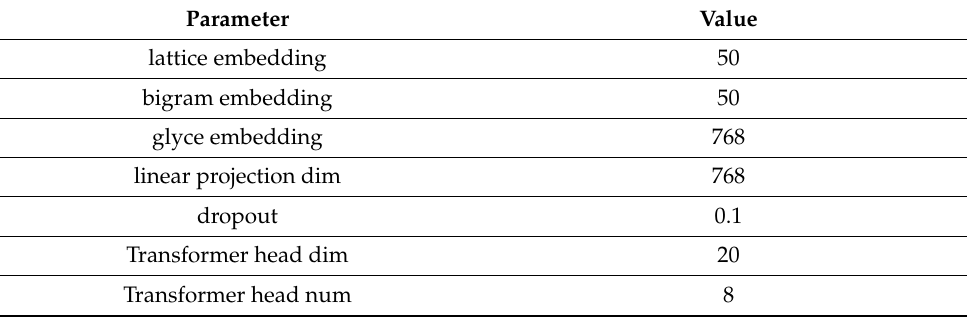
Table 2. Parameter